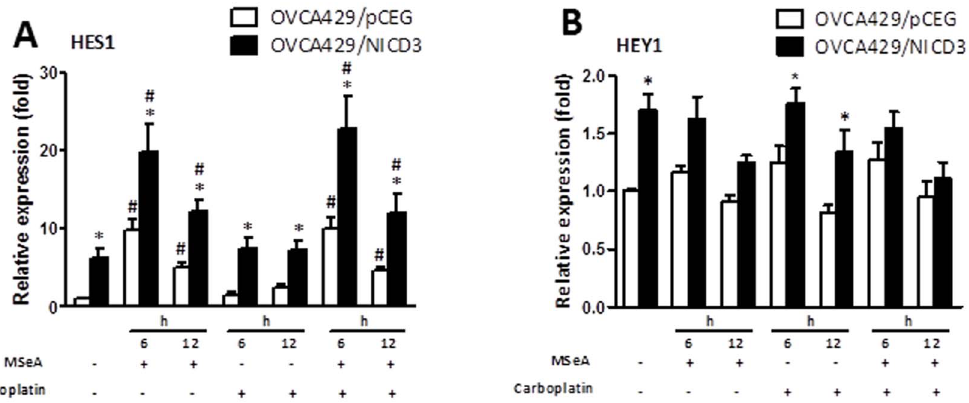
Figure 4. The effect of MSeA and carboplatin on the mRNA expression of HES1 and HEY1 in OVCA429/pCEG and OVCA429/NICD3 cells. The mRNA levels were normalized by those of b -actin and presented as fold changes relative to the OVCA429/pCEG cells without MSeA (2 m mol/L) and carboplatin (25 m mol/L) treatment. Values are mean 6 S.E.M. (n = 3). *, p , 0.05, compared to OVCA429/pCEG cells. # , p , 0.05, compared to cells without MSeA and carboplatin